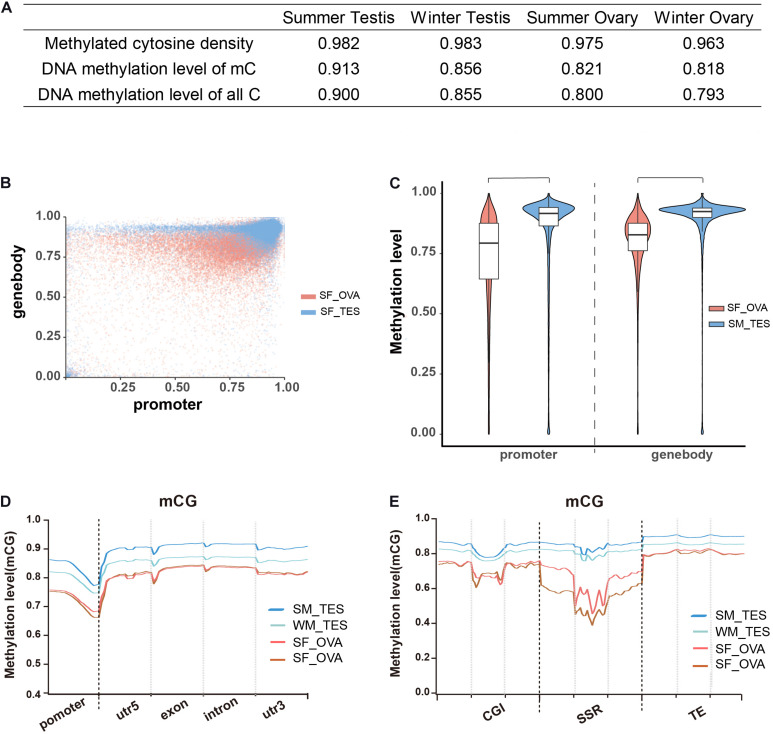
Overall DNA methylation patterns of CG context in adult Chinese alligator gonads. (A) The DNA methylation density and level of gonad samples. (B) Methylation levels of genes in the ovary and testis collected in summer. (C) Violin plot of the methylation levels of genes in the ovary and testis collected in summer. (D) DNA methylation levels in different elements of genes in the gonads of adult Chinese alligators. Promoters encompass the 2-kb region upstream of the transcription start site. (E) DNA methylation levels in CG islands (CGI), simple-sequence repeats (SSR), and transposable elements (TE) and 2-kb regions upstream and downstream of genes in the gonads of adult Chinese alligators.